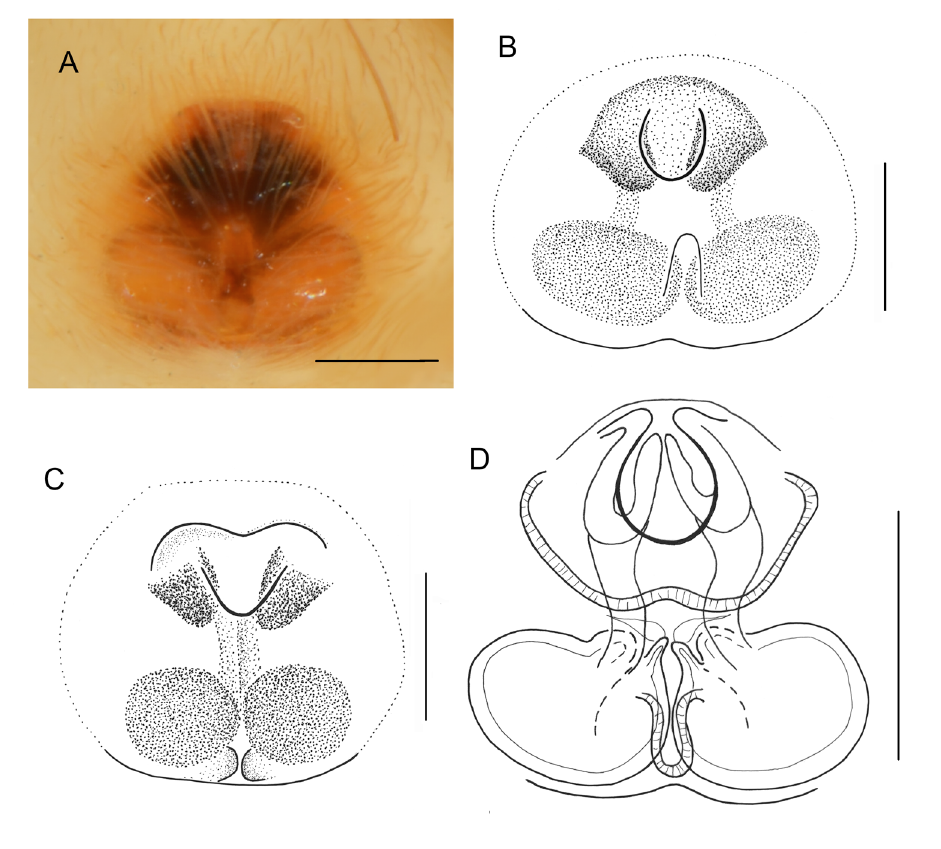
Fig. 15. Pochytoides spiniger sp. nov., paratypes, ♀. A–C . Epigyne. D . Internal structure of epigyne. scale bars: 0.2